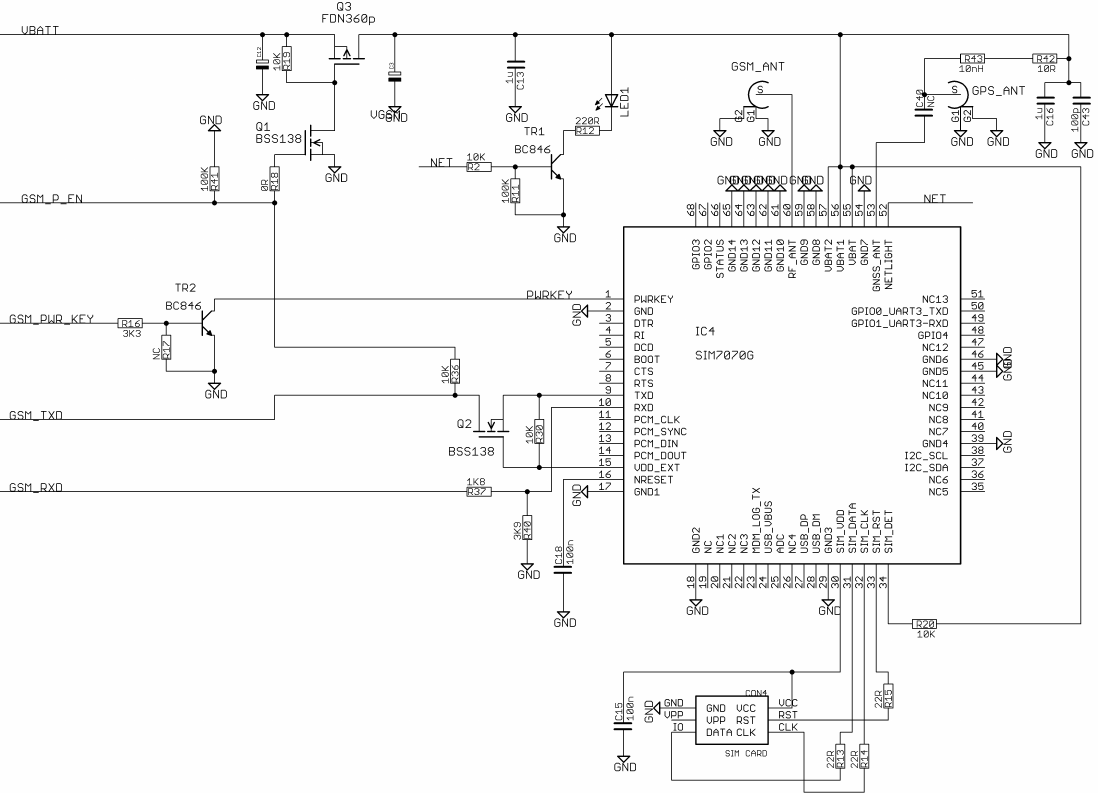
Figure A7. The schematic diagram of the communication circuit. It is based on simcom's SIM7070G Cat-M/NB LTE GSM module. It connects via a UART port to the main processor and sends the data to the server with a POST request.